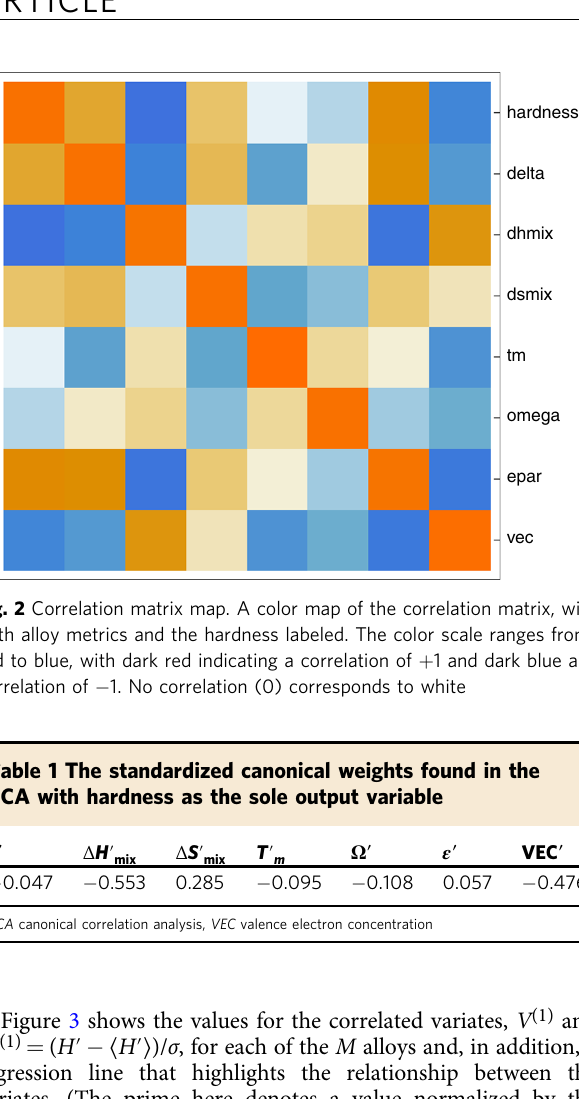
Figure 3 shows the values for the correlated variates, V (1) and W (1) = ( H ′ − 〈 H ′ 〉 )/ σ , for each of the M alloys and, in addition, a regression line that highlights the relationship between the variates. (The prime here denotes a value normalized by the reference alloy, the angle brackets denote an average over a dataset comprising the M = 82 HE alloys, and σ denotes the standard deviation in H ′ over the dataset). Despite the adequacy of the reduced model, for greater accuracy the multiple regression analysis for the full model will be used below to identify promising alloys.